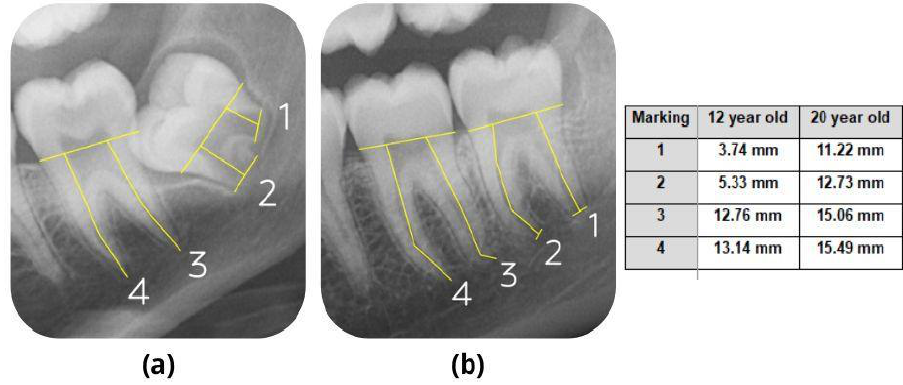
Figure 1. Measurement of mesial and distal root lengths of left mandibular second and third molars in ( a ) 12–years–old female patient and ( b ) 20–years–old male patient.